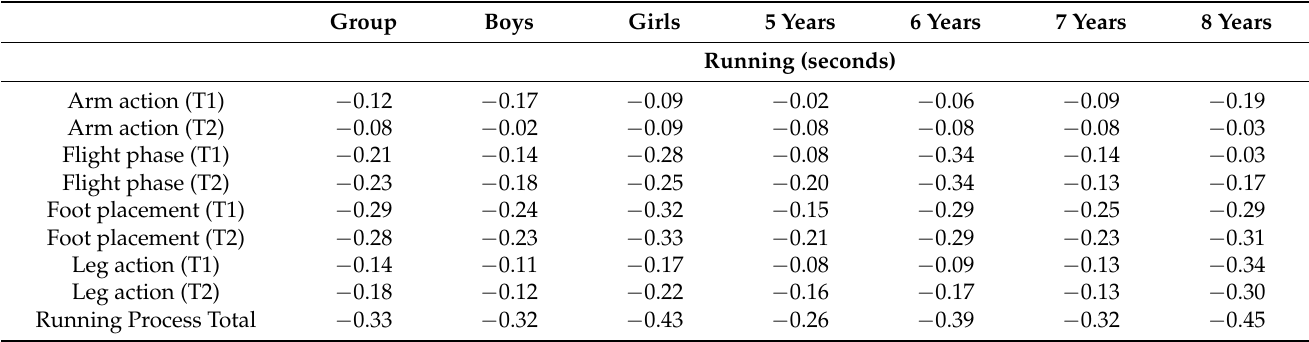
Table 5. Associations between the process and product assessments of running, catching, kicking, and jumping skills, per group, sex, and